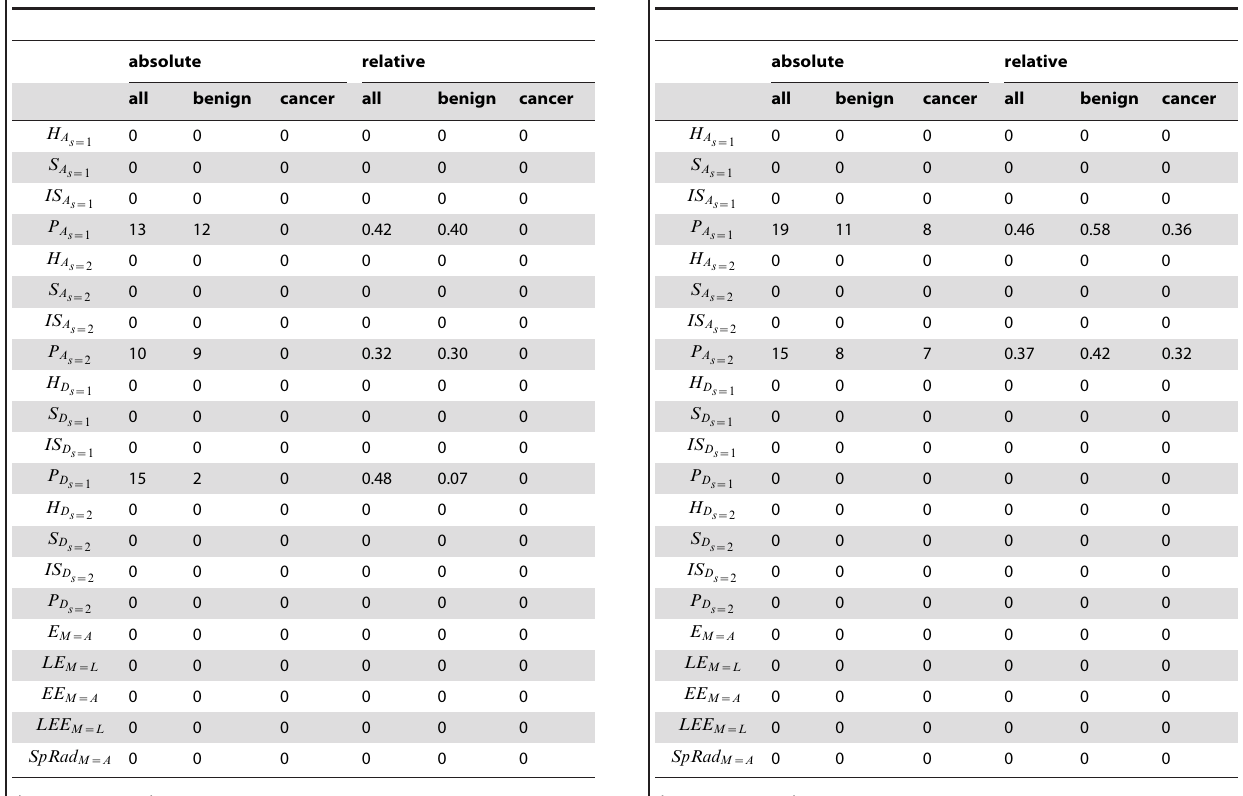
Table 8. ndV-values for the structural biomarkers (eigenvalue and entropy-based measures) for prostate cancer networks and the corresponding subgroups (benign/cancer) for [54].